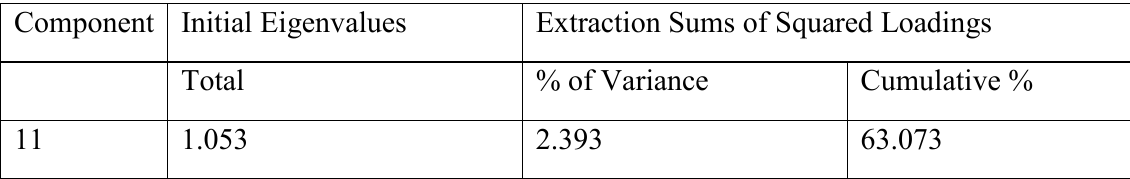
Table 1.21: Variance explained for Absorptive Resilience PC11